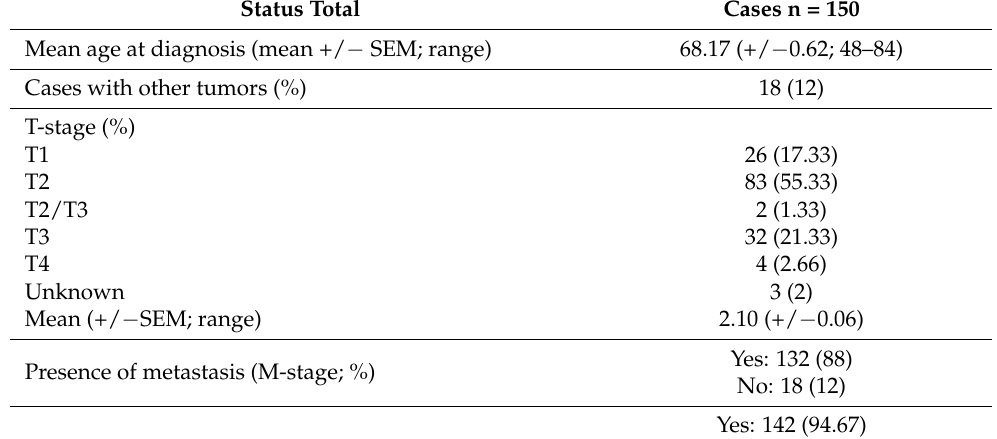
Table 1. Clinicopathological characteristics of the 150 patients included in this study.